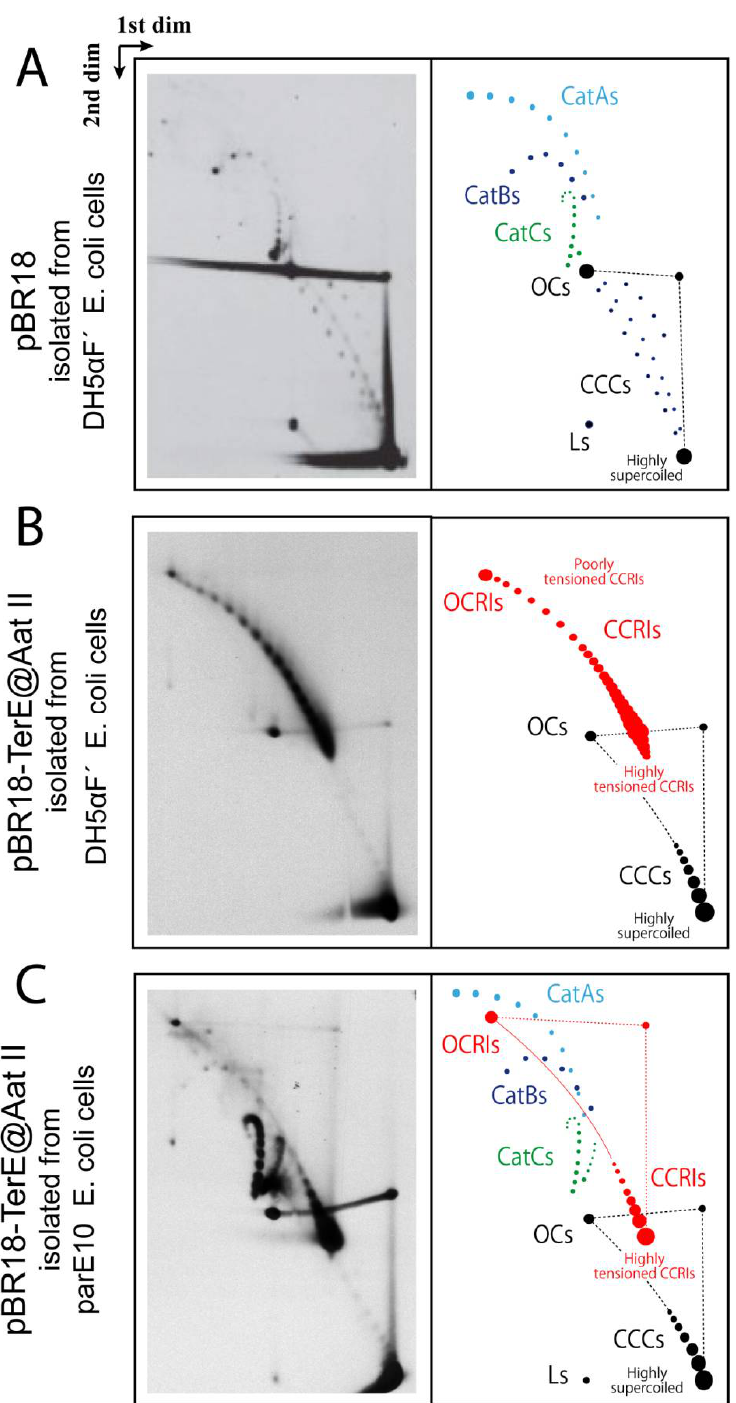
Figure 3. Immunograms and interpretative cartoons of intact untreated forms of pBR18 and pBR- TerE@ AatII isolated from either DH5αF’ ( A , B ) or parE10 ( C ) E. coli cells analyzed by two-dimensional agarose gel electrophoresis. Non-replicating CCCs and OCs are depicted in black. Partially replicated CCRIs and OCRIs are depicted in red. The final position of highly supercoiled CCCs as well as highly and poorly tensioned CCRIs is indicated. In addition, when visualized, the position of CatAs is depicted in light-blue, CatBs in dark blue and CatCs in green.